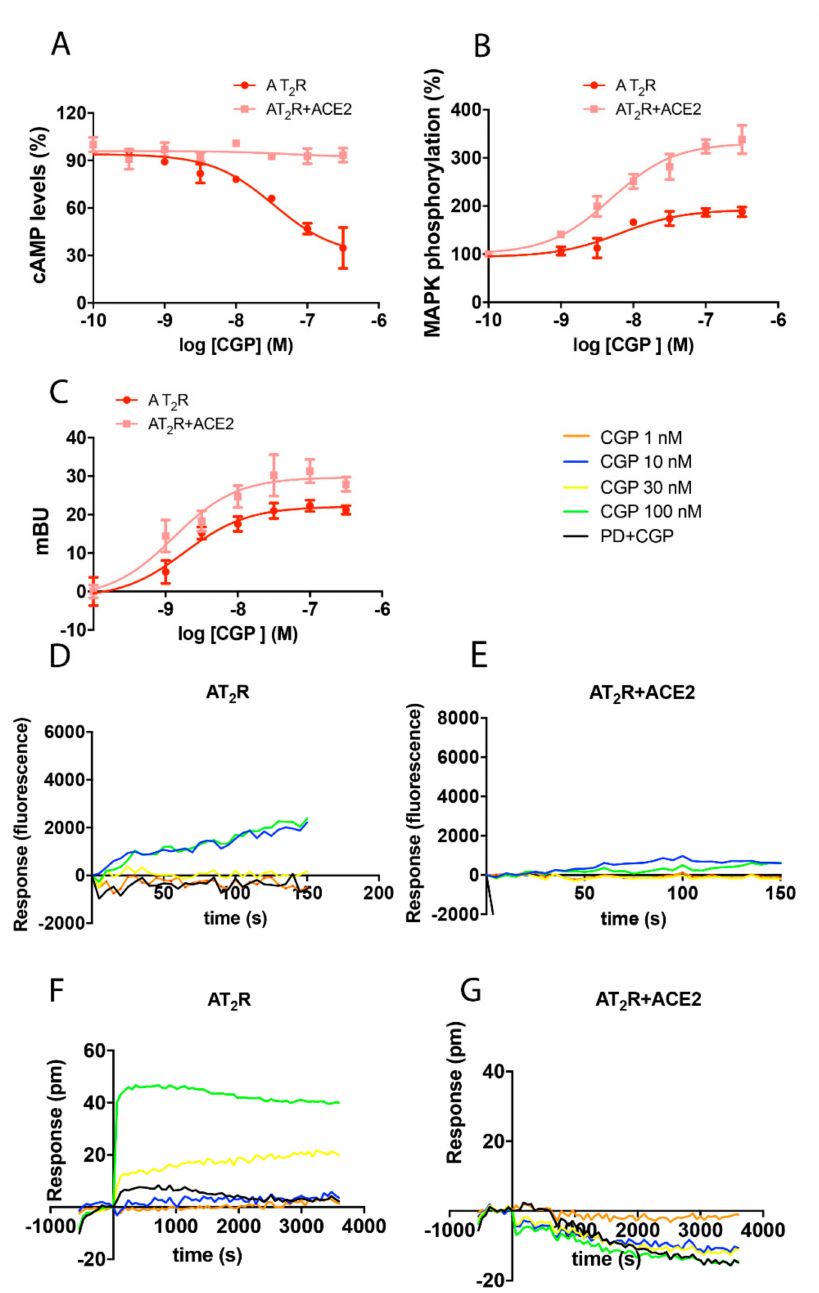
Figure 2. Impact of ACE2 on the functionality of AT 2 R. HEK-293T cells were transfected with either 0.3 µ g AT 2 R cDNA and 0.2 µ g ACE2-HA cDNA ( A , B , F , G ), 0.4 µ g AT 2 R-YFP cDNA, 0.2 µ g ACE2-HA cDNA, and 0.5 µ g β -arrestin II-RLuc cDNA ( C ), or 0.3 µ g AT 2 R cDNA, 0.2 µ g ACE2-HA cDNA, and 0.5 µ g cDNA encoding the Ca 2 + sensor, GCaMP6 ( D , E ). After 48 h of incubation, cells were treated with increasing concentrations of the selective AT 2 R agonist, CGP. Cyclic AMP was measured after 15 min in response to pre-treatment with 0.5 µ M forskolin ( A ); see also Legend to Figure 4. Results from the evaluation of ERK1 / 2 phosphorylation ( B ), β -arrestin II recruitment ( C ), Ca 2 + levels ( D , E ), and DMR recordings ( F , G ) are presented as dose-response curves. Where indicated, cells were pre-treated with selective AT 2 R receptor antagonist, PD123319 (PD; 1 µ M), before challenge with the receptor agonist. Values are the mean ± SEM of 8 independent experiments each performed in